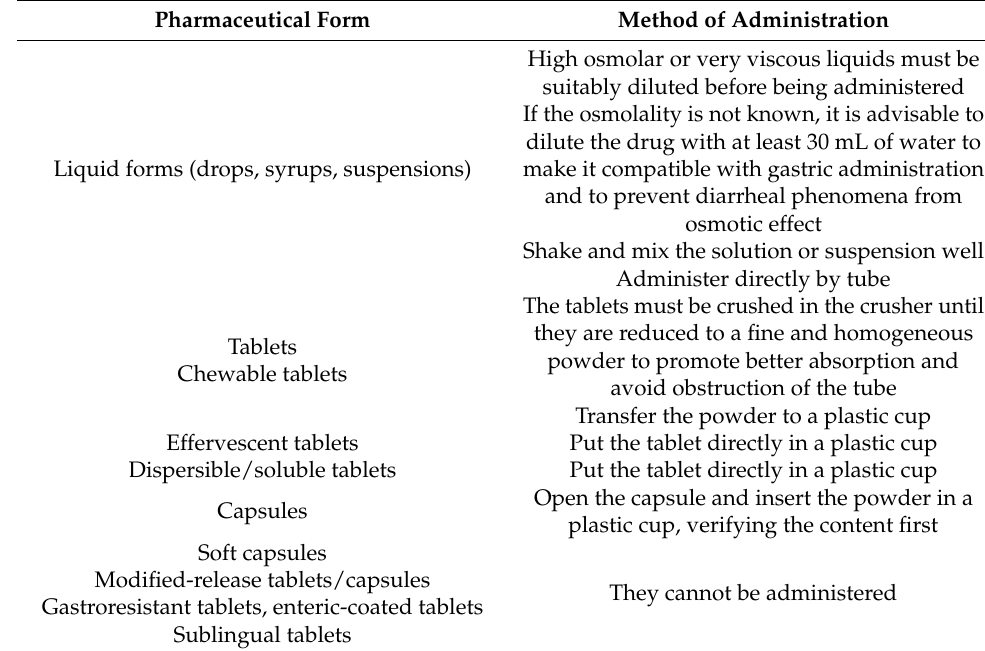
Table 5. General recommendations for medications given by